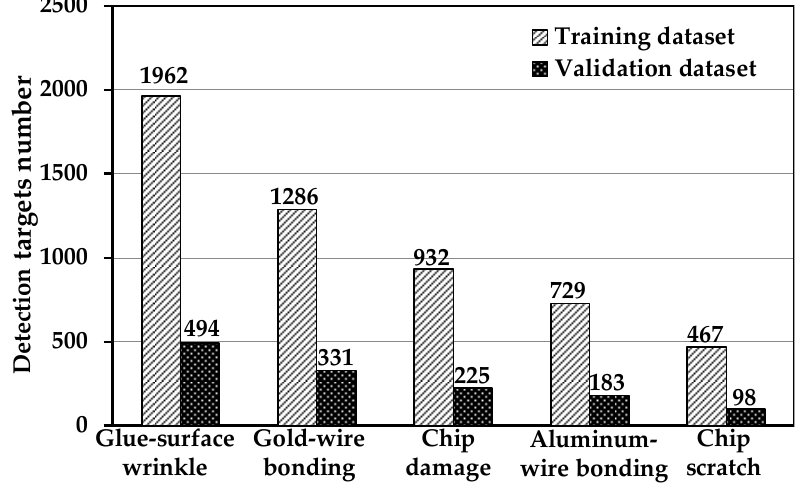
Figure 6. Numbers of five detection targets of MEMS pressure sensors.